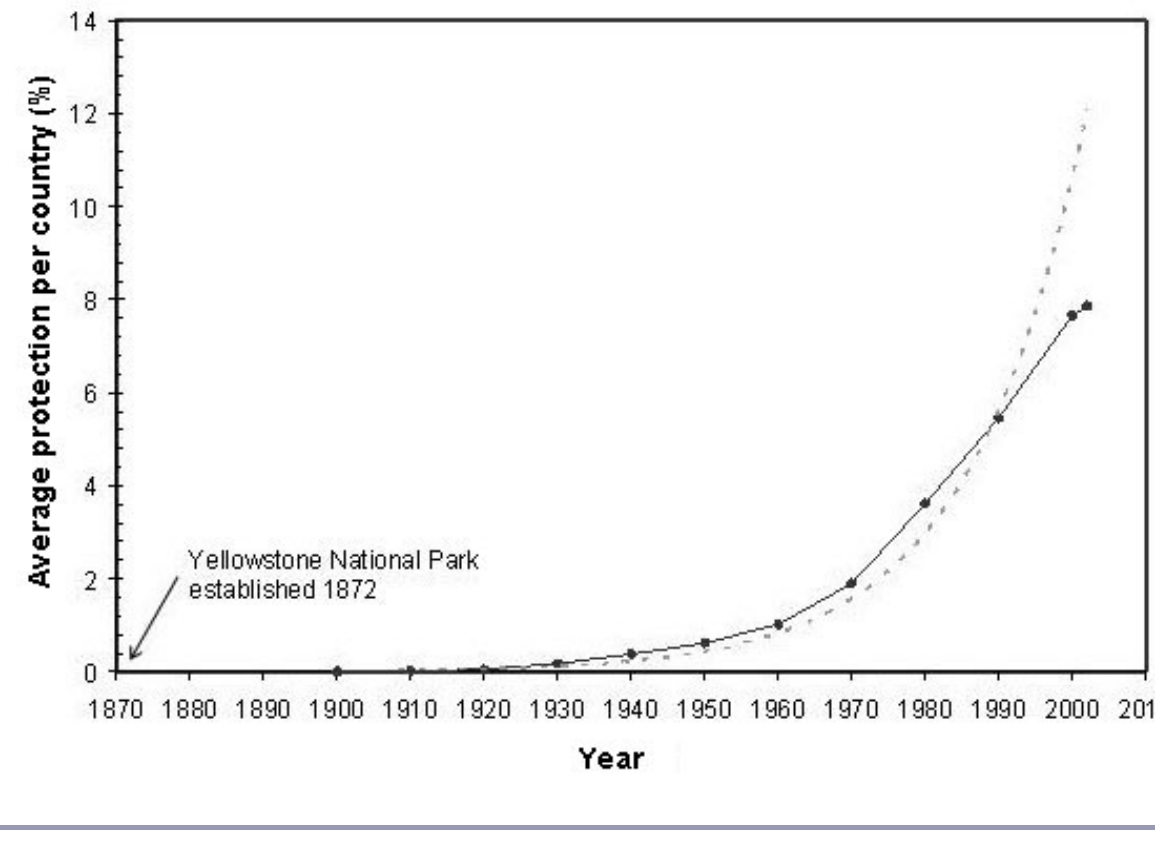
Fig. 1. Global growth of protected areas since 1900. The dashed line illustrates a fitted exponential curve. The establishment of Yellowstone National Park in 1872 marked the beginning of development of the now-traditional concept of protected areas, i.e., the withdrawal of land from settlement, occupancy, or sale for the benefit and enjoyment of